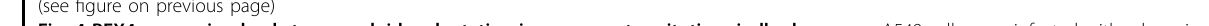
Fig. 4 BEX4 expression leads to aneuploidy adaptation in response to mitotic spindle damage. a A549 cells were infected with adenovirus (rAd) expressing a control GFP or GFP-BEX4, and the levels of GFP and GFP-BEX4 were analyzed by immunoblotting. b A549 cells expressing GFP or GFP-BEX4 were fi xed with 4% paraformaldehyde, and stained with DAPI to visualize DNA. Scale bars represent 10 μ m. c The percentage of multinucleated cells was calculated using at least 100 cells per experiment. ** P < 0.01. d Doxycycline-treated GFP- or GFP-BEX4-inducible cells were treated with nocodazole (200 ng/ml). At the times indicated, the cells were harvested and stained with propidium iodide. DNA contents were analyzed by fl ow cytometry. e Histograms summarizing the distribution of different DNA contents in cells analyzed in ( a ). The results are the mean ± SEMs of three independent experiments. f Immunoblots with anti-GFP, anti-poly(ADP-ribose) polymerase-1 (PARP), anti-cleaved-caspase 9, anti- cleaved-caspase 7, anti-cleaved-caspase 3, anti-cIAP-1, and anti- β -actin antibodies in the cells analyzed in ( d